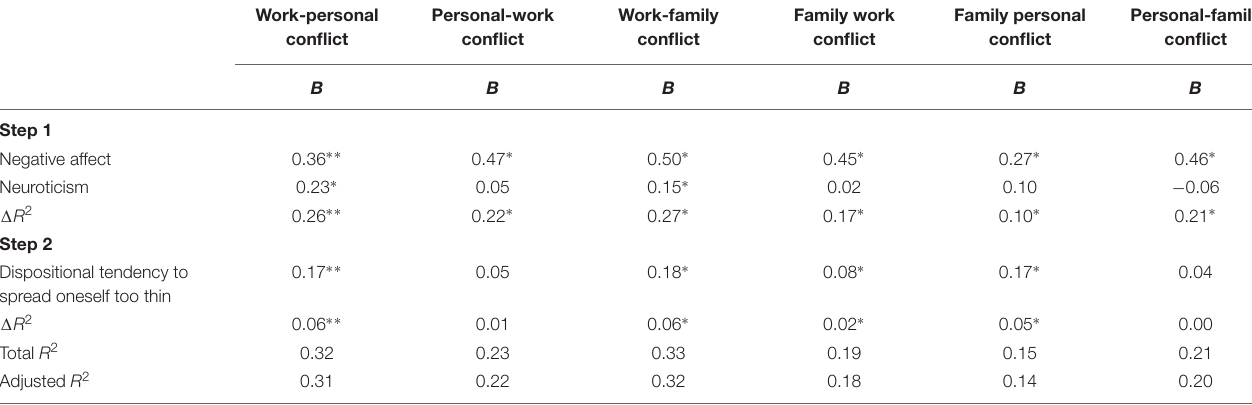
TABLE 2 | Incremental effects of the dispositional tendency to spread oneself too thin on role